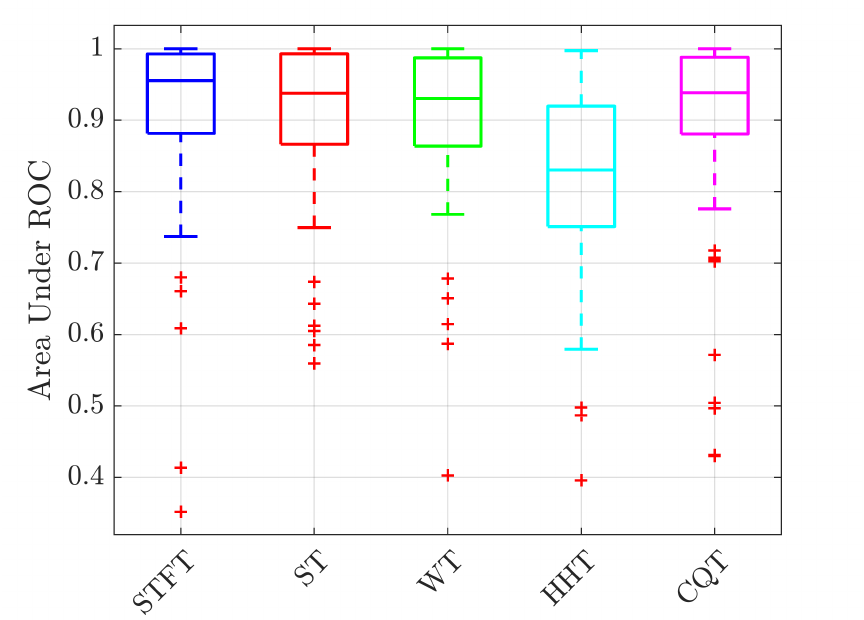
Figure 6. Boxplot of the Area Under ROC (AUR) for the considered pre-processing strategies. Each boxplot includes mean results for 3 gestures and 25 subjects.